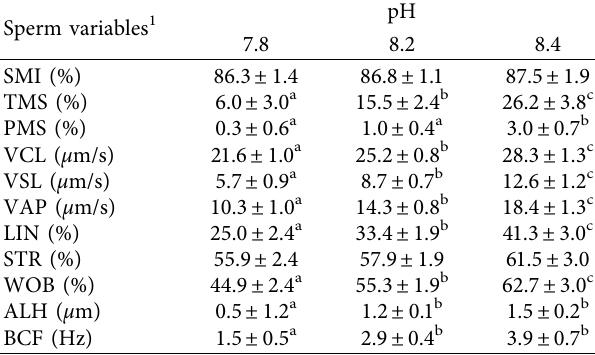
Table 3: Sperm viability and CASA parameters (LSMeans ± SE) measured in budgerigar semen samples diluted in Lake extender (LE) at different